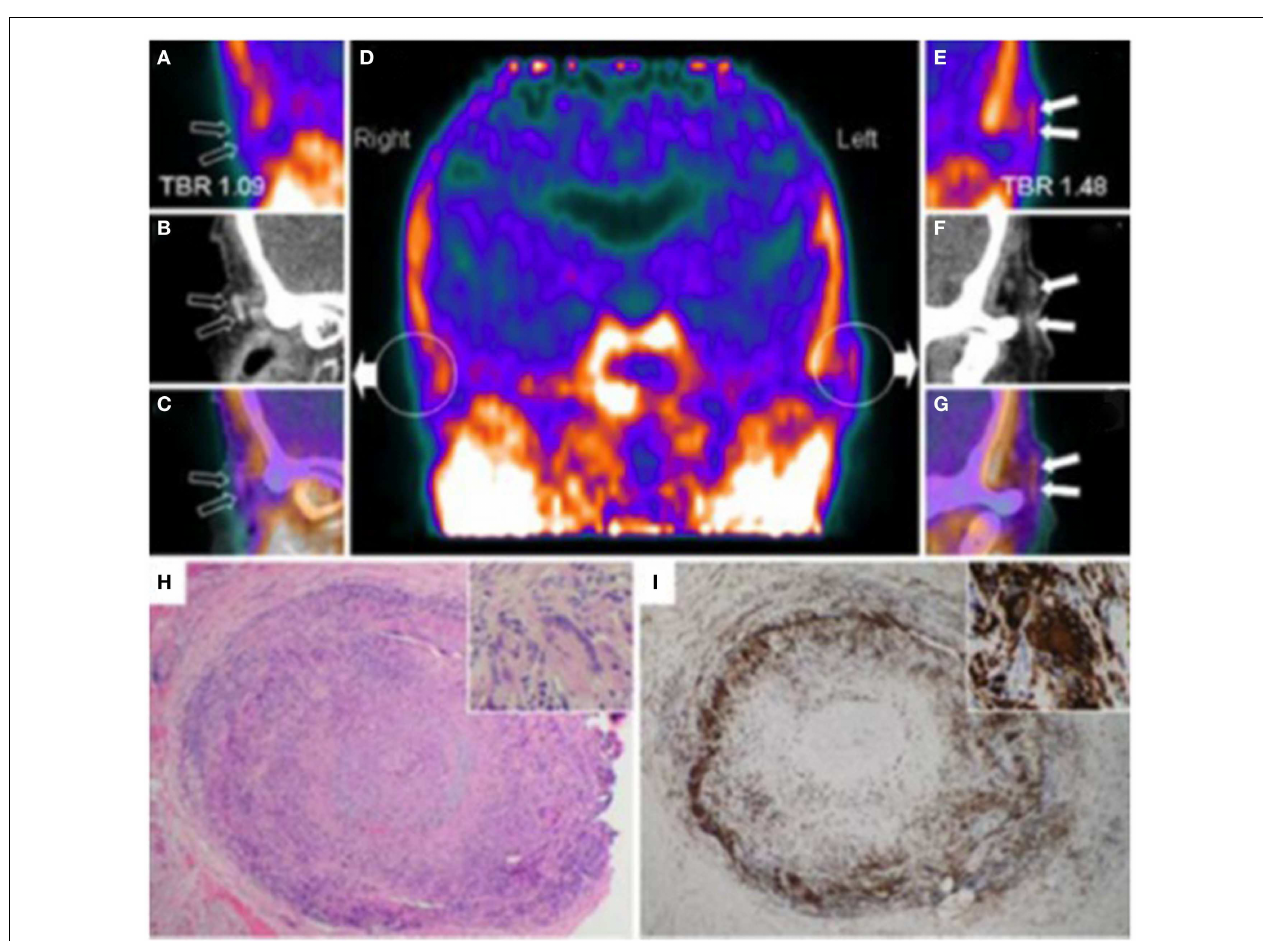
The H&E biopsy specimen (H) of the left temporal artery (4 × objective) shows transmural granulomatous infiltration (containing activated lymphocytes, macrophages, and multinucleated giant cells), secondary myofibroblast proliferation, and significant intimal thickening leading to luminal obliteration. Large part of the media and the internal elastic lamina are destroyed.The inset (H&E, × 100 objective) demonstrates a multinucleated giant cell. CD68 (macrophage marker, shown in panel I) staining brown with immunoperoxidase ( × 4 objective) shows dense macrophage infiltration with multinucleated cells (inset, × 100 objective). [adapted with permission from